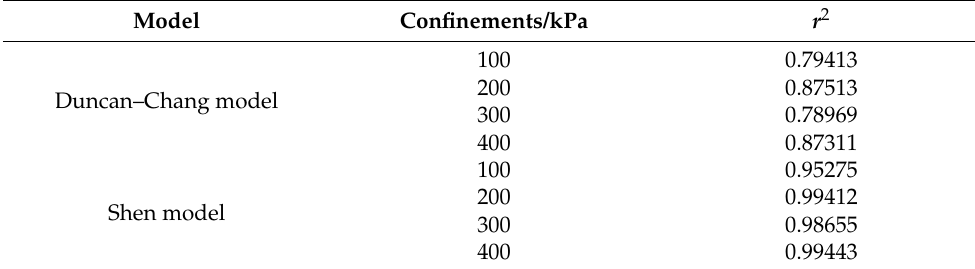
Table 7. Coefficient of determination adopting two